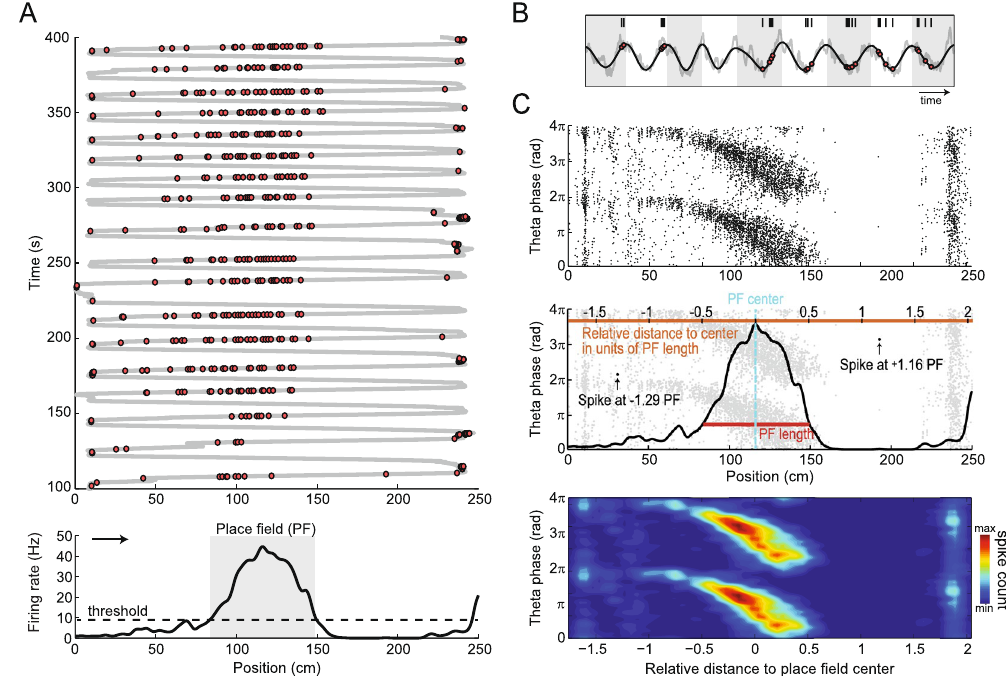
Figure 1. Spatial normalization by place field length. ( A ) Top, trajectory of a rat running back and forth on a linear track (gray line); red circles represent spikes of a place cell. Bottom, firing rate of the same cell as a function of position during runs to the right (arrow). The dashed line denotes the threshold used to estimate the length of the place field (gray shade). ( B ) Example of phase precession during a run to the right. Gray/white shades mark theta cycles. ( C ) Top, black dots represent all spikes of the cell in A as a function of position in cm (x-axis) and theta phase (y-axis). Middle, scheme of spatial normalization. Light gray dots represent spikes. The center of the place field was defined as the position of maximum firing rate. The orange horizontal scale on top shows the distance to the place field center in units of place field length. Arrows highlight the relative distance of two spikes. Bottom, heat map representation of spike counts per relative distance and theta